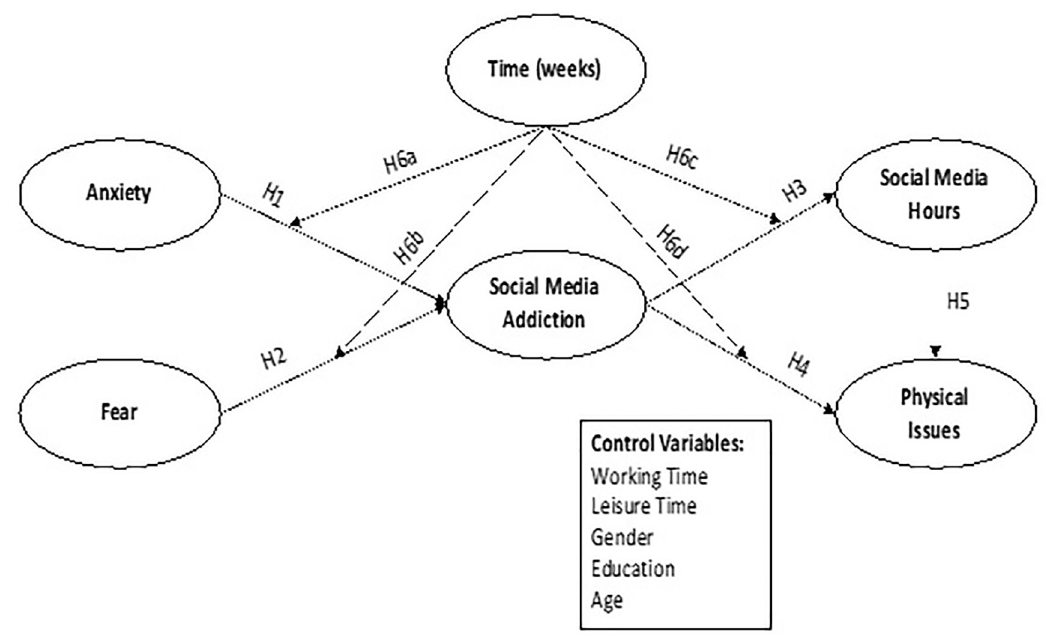
Fig 1. Conceptual framework for the model (based on Brunborg and Burdzovic, 2019 [26]; Coyne et al., 2020 [27]).